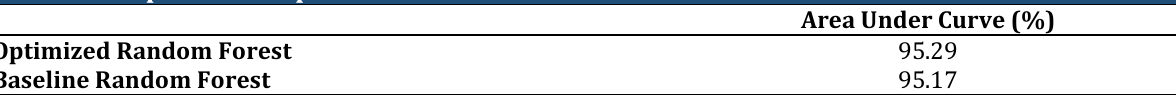
Table 3: Comparison of optimized and baseline random forest model